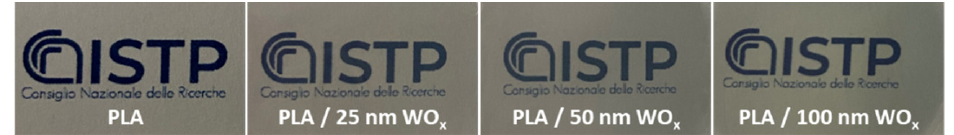
Figure 6. Photos of pristine PLA and PLA coated with three different WO x coating thicknesses.